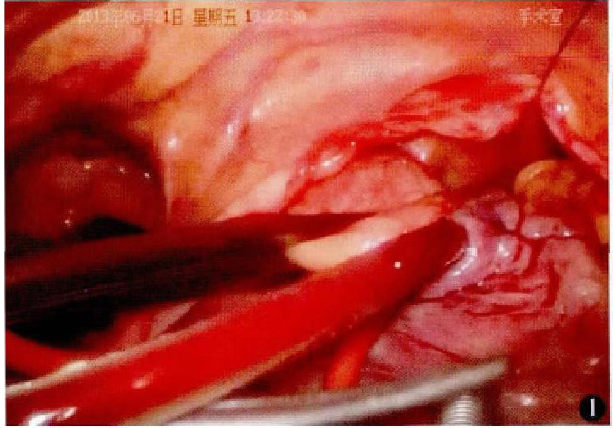
Fig. 2 - Ascending aortic clamping under thoracoscopic approach.